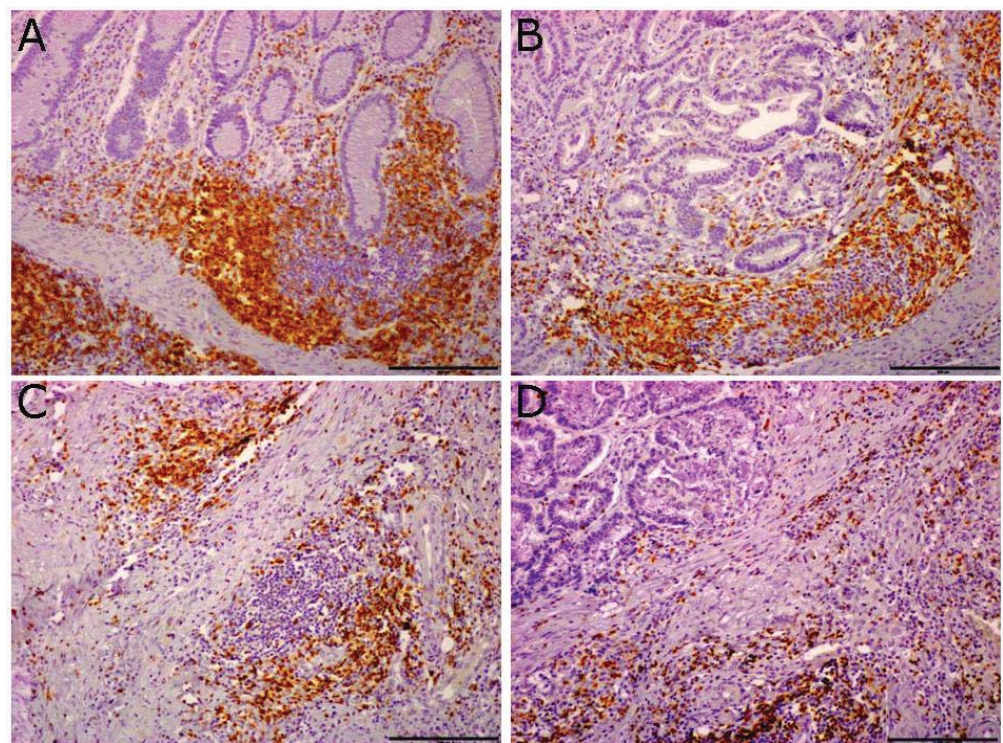
Figure 1. Tertiary lymphoid tissue in sections of human colo-rectal tumors. Immunohistochemistry with an anti-CD3 + antibody allows identification of lymphoid tissue in human colon mucosa. Lymphoid tissue is present in normal mucosa, at the bottom of the crypts ( A ) and in tumor sections, both adjacent to tumor nests ( B ) and in tumor-associated stromal tissue ( C ); CD3 + T lymphocytes scattered in the tissue are shown in ( D ). Scale bar = 200 μ m.